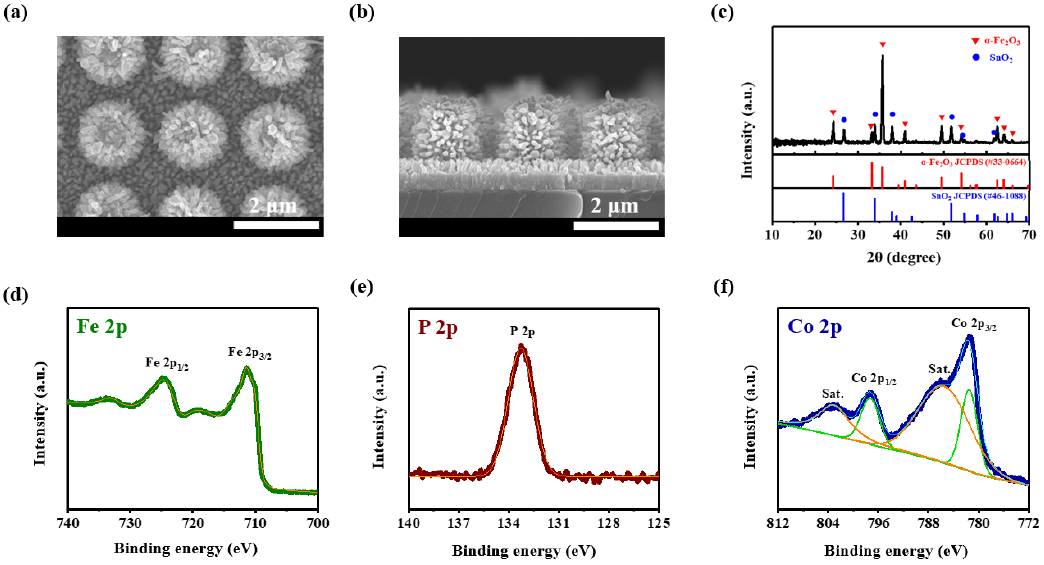
Figure 2. ( a , b ) SEM images of the Fe 2 O 3 nanorods on FTO-M. ( c ) XRD patterns of the FTO-M/Fe 2 O 3 . X-ray photoelectron spectroscopy (XPS) profiles of the Fe 2 O 3 /Co – Pi sample. ( d ) Fe 2p, ( e ) P 2p, ( f ) Co